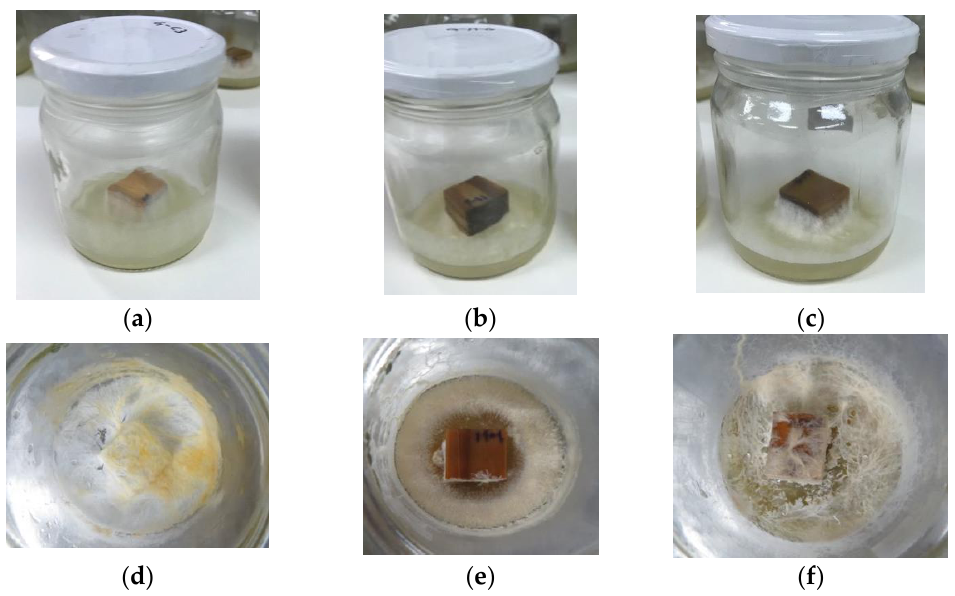
Figure 7. Photographs of radiata pine samples exposed to biodeterioration. ( a , d ) control sample; ( b , e ) sample impregnated with CuNPs; and ( c , f ) leached sample. Images ( a – c ) correspond to samples at week 4 of exposure to G. trabeum . Images ( d – f ) correspond to samples at week 16 of exposure to G. trabeum .